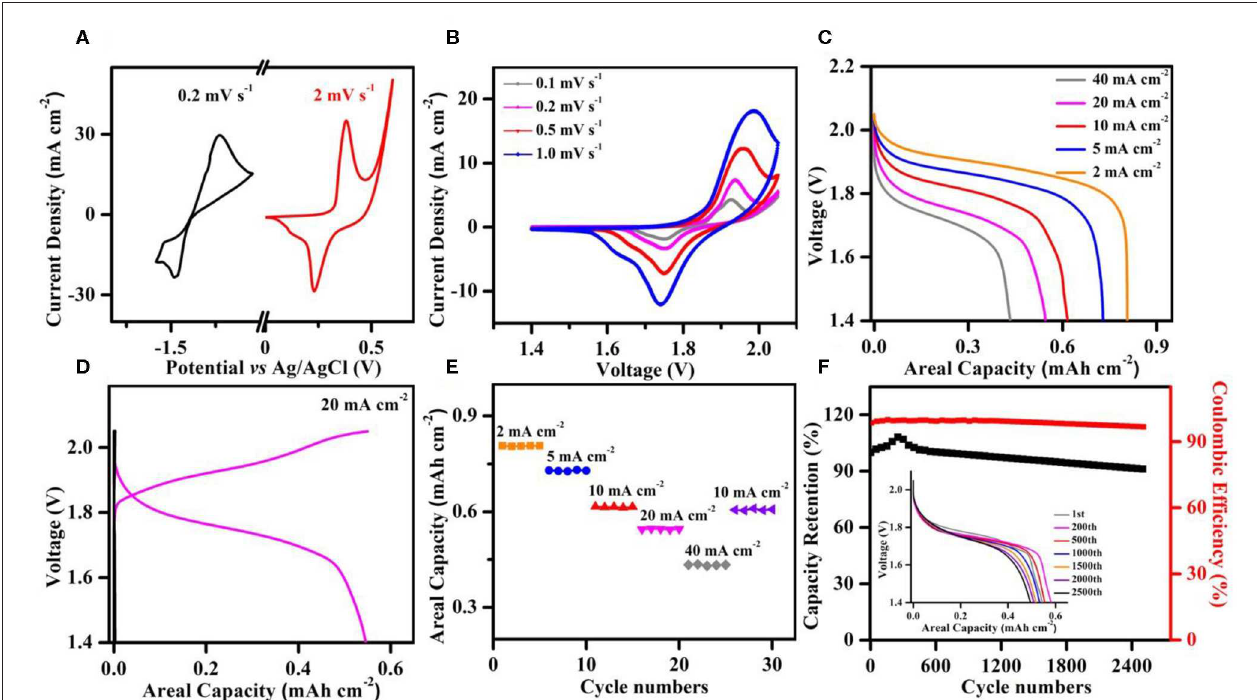
FIGURE 5 | (A) Comparison of CV curves of Ni,Cu-MOF anode and Zn cathode at 0.2 and 2mV s − 1 , respectively. (B) CV curves of full cell with the charge–discharge densities changed from 2 to 40mA cm − 2 . (C) Galvanostatic discharge profiles of the Ni,Cu-MOF//Zn at different current densities from 2 to 40mA cm − 2 . (D) Charge–discharge curves of Ni,Cu-MOF//Zn and nickel foam//Zn batteries at 20mA cm − 2 . (E) Long-term stability and reversibility of Ni,Cu-MOF//Zn battery with the charge–discharge densities changed from 2 to 40mA cm − 2 . (F) Cycling performance of the Ni,Cu-MOF//Zn battery collected for 2,500 cycles. The inset is the comparison of discharge curves after 1st to 2500th cycles.